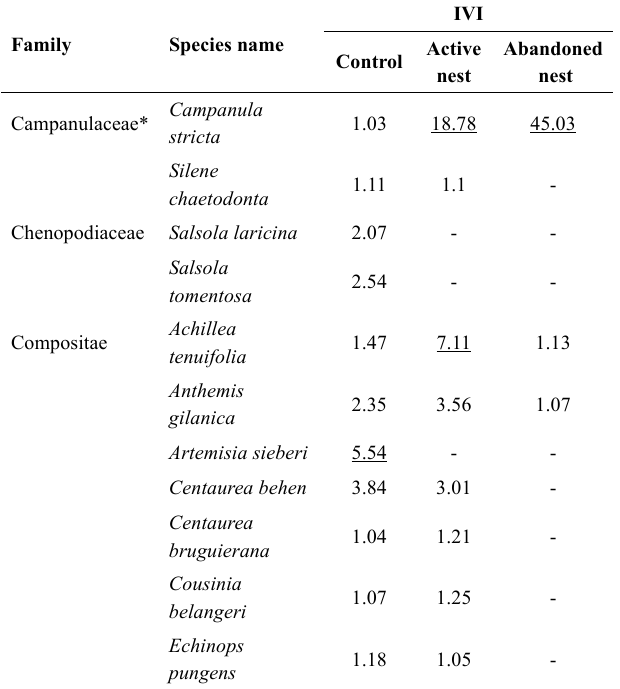
Table 3 . Above: Mean importance value index (IVI) for plants species and mean (± SE) percentage cover of different functional groups of plants. Below: Plant species richness (S), diversity (H'), and evenness (E) for active and abandoned Messor cf. intermedius nests and control sites (Mean ±